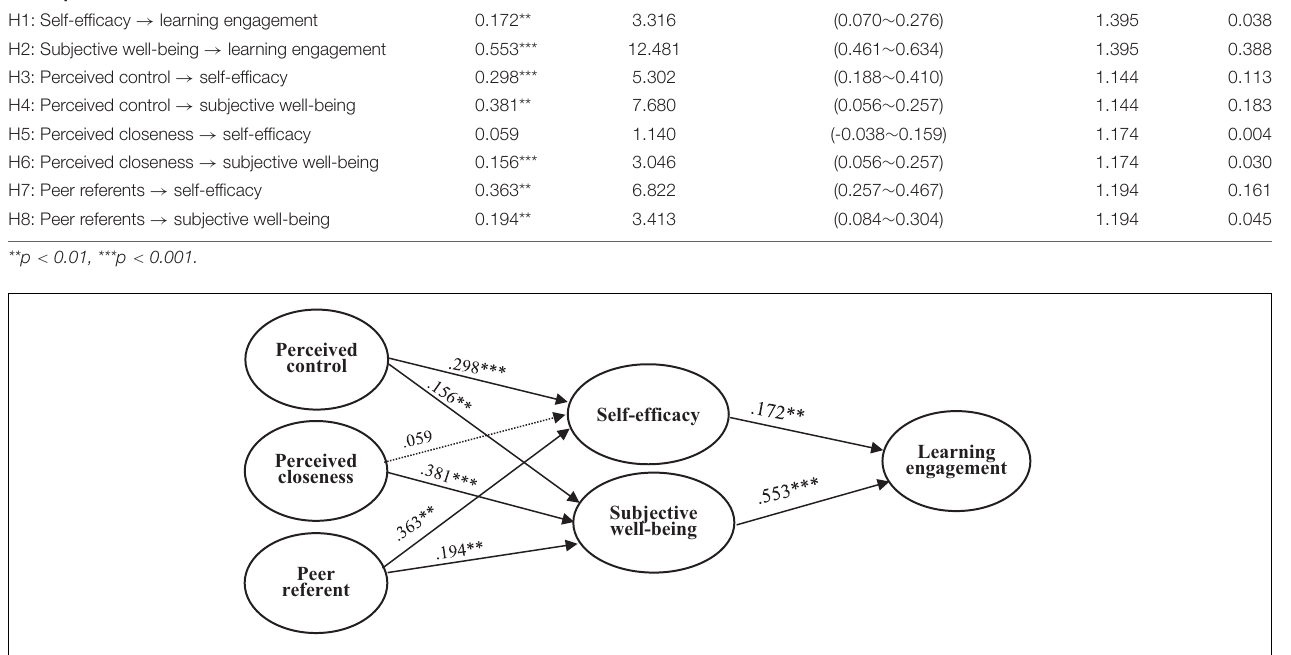
FIGURE 2 | Structural model. ∗∗ p < 0.01 and ∗∗∗ p <